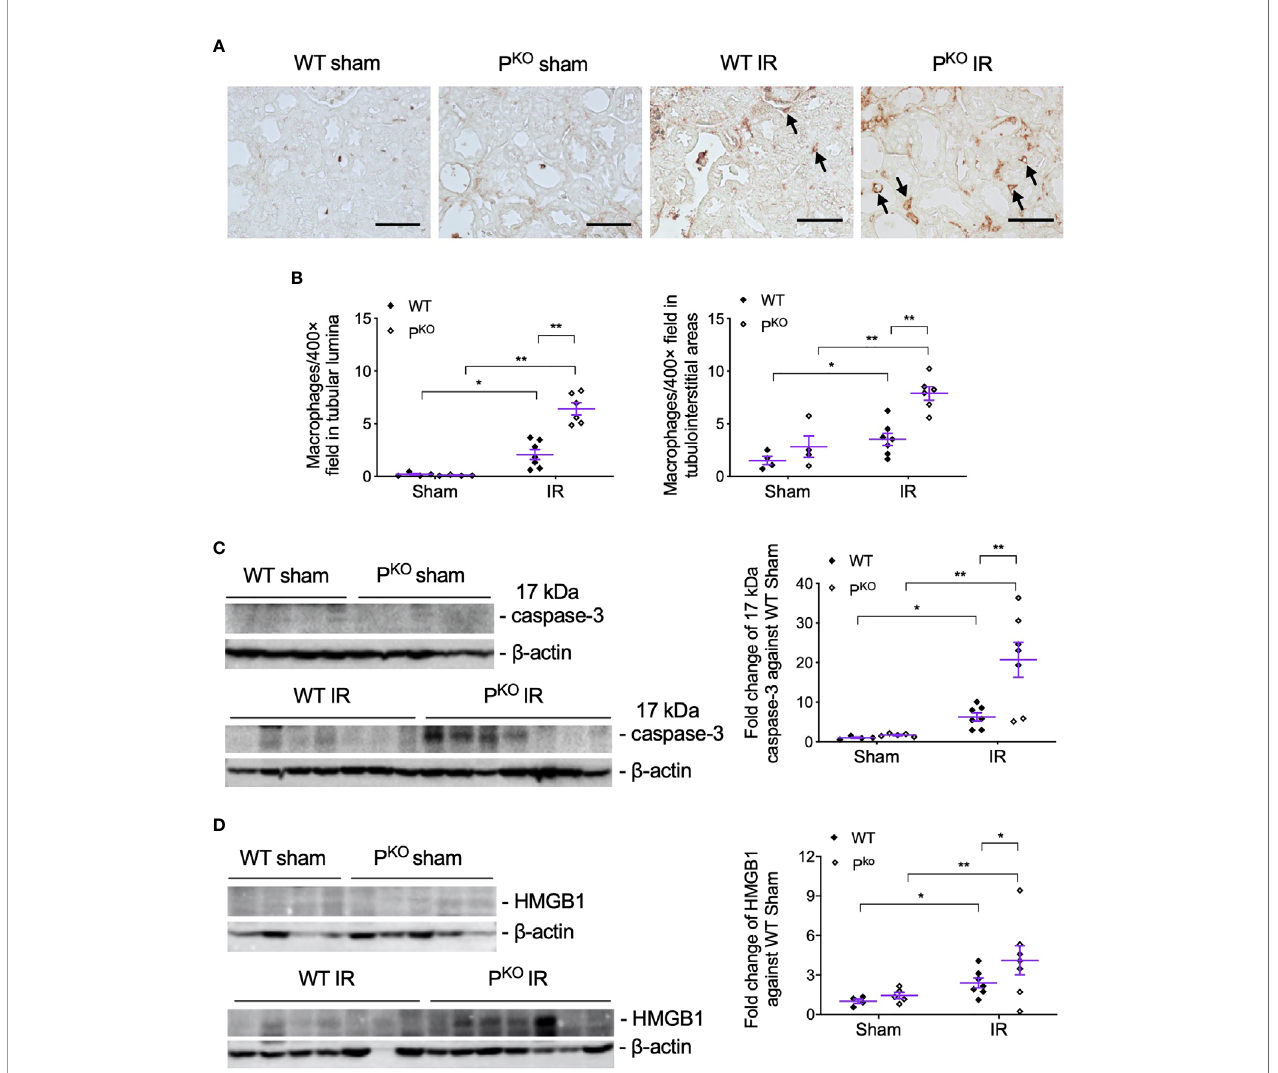
FIGURE 3 | P KO increased the in fi ltration of in fl ammatory cells and the expression of injury markers post IR at 72 h. (A, B) Representative images of F4/80 immunostaining in the indicated groups, and the semiquantitative analysis, showed more F4/80+ cells in the interstitium and tubulointerstitium of P KO kidneys than WT controls (sham: n = 4; IR: n = 6 – 7). The images were taken from the cortical area of the kidney. Scale bar: 50 m m. (C, D) Seventeen kilodaltons active caspase-3 and HMGB1 protein in the kidney determined by Western blot was increased by IR and furthered by P KO (sham: n = 4-5; IR: n = 7 – 9). Data were shown as means ± SEMs and analyzed by one-way ANOVA and LSD test. * p < 0.05; ** p <